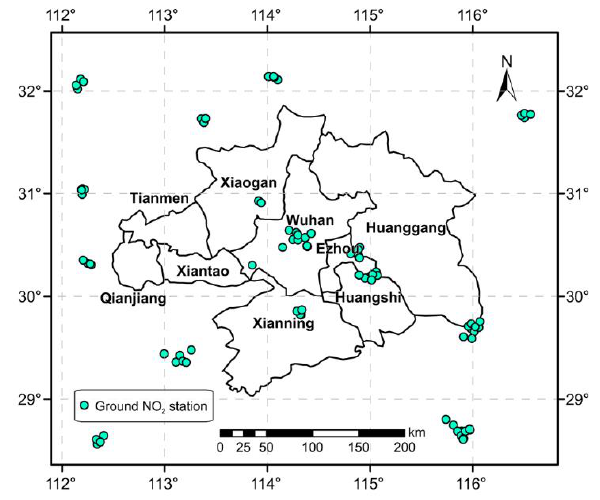
Figure 1. The WUA region and the distribution of ground NO 2 stations.